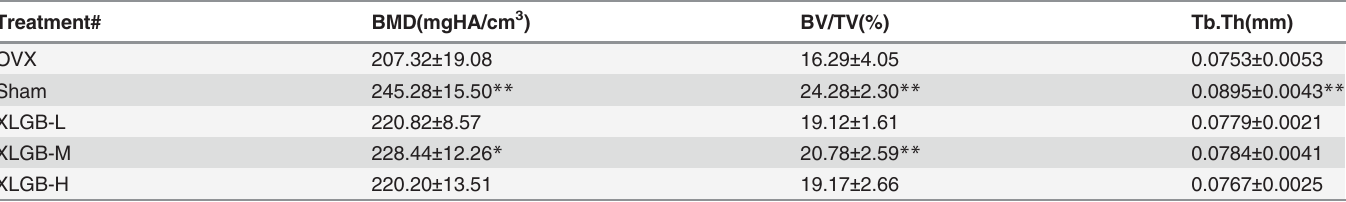
Table 2. Effects of three doses of XLGB extracts on bone parameters as measured by microCT at the sixth lumbar vertebrae in OVX mice (mean values ± standard deviations, n = 10).